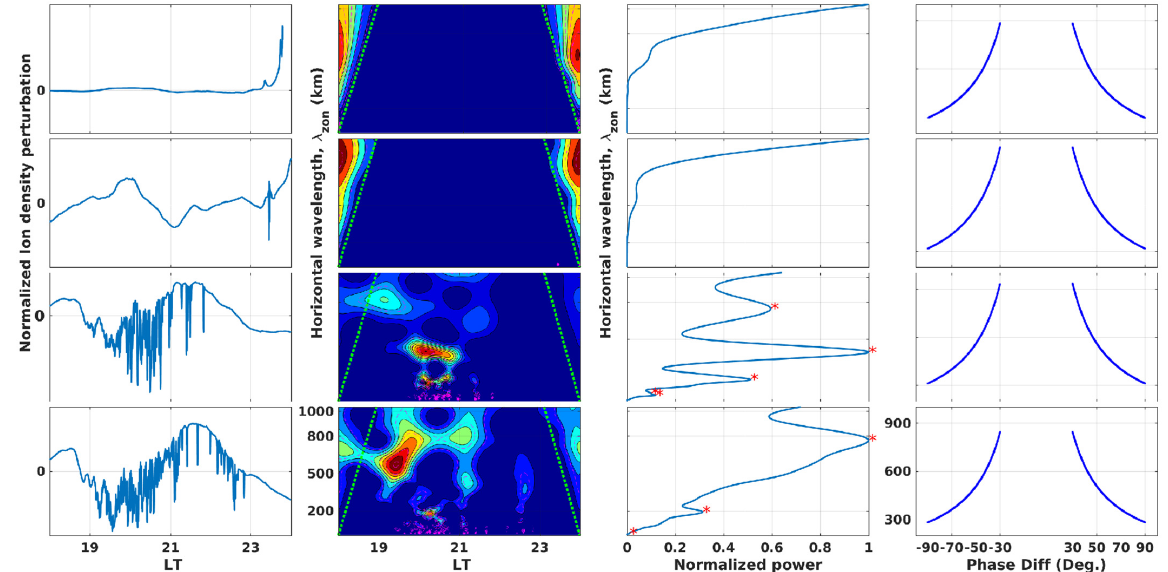
Figure 13. Normalized ion density perturbation ( left panels ) for non-irregular ( 1st and 2nd rows ) and irregular ( 3rd and 4th rows ) versus LT, contour map of wavelet power of normalized ion density fluctuations shown in the 1st column versus zonal wavelength and LT ( 2nd column from the left , deep red and blue colors represent dominant and weak power, 95% confidence intervals are represented by magenta color dashed line curves) and time integrated normalized wavelet power of normalized ion density fluctuations versus zonal wavelength ( 3rd column from the left ), and gravity wave zonal wavelength versus phase shift ( 4th column from the left ) on 14 October 2011. The asterisks in the third column represent peak value of time integrated normalized wavelet power.